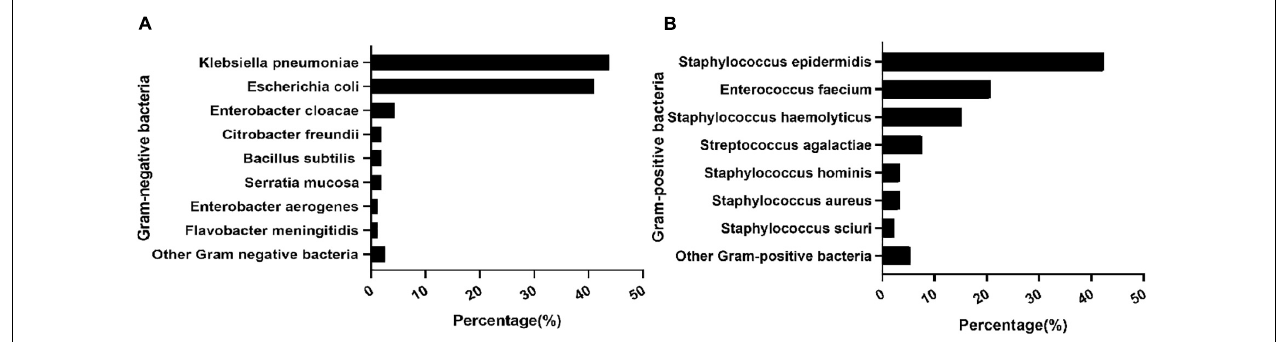
FIGURE 1 | Distribution of pathogens. Composition of major Gram-positive bacteria (A) . Composition of major Gram-negative bacteria (B) .